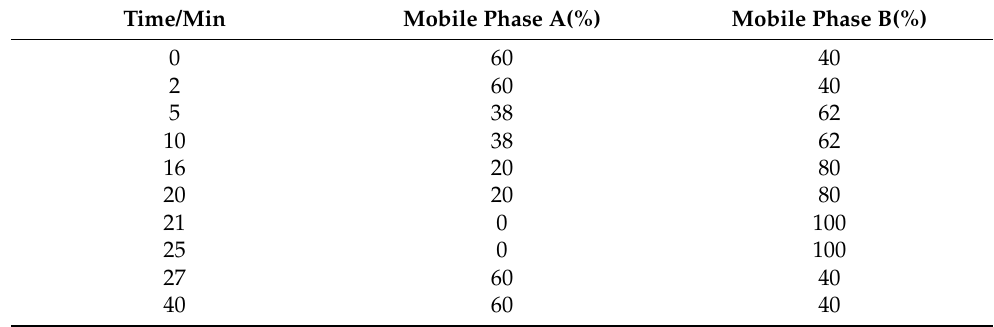
Table 1. Gradient elution